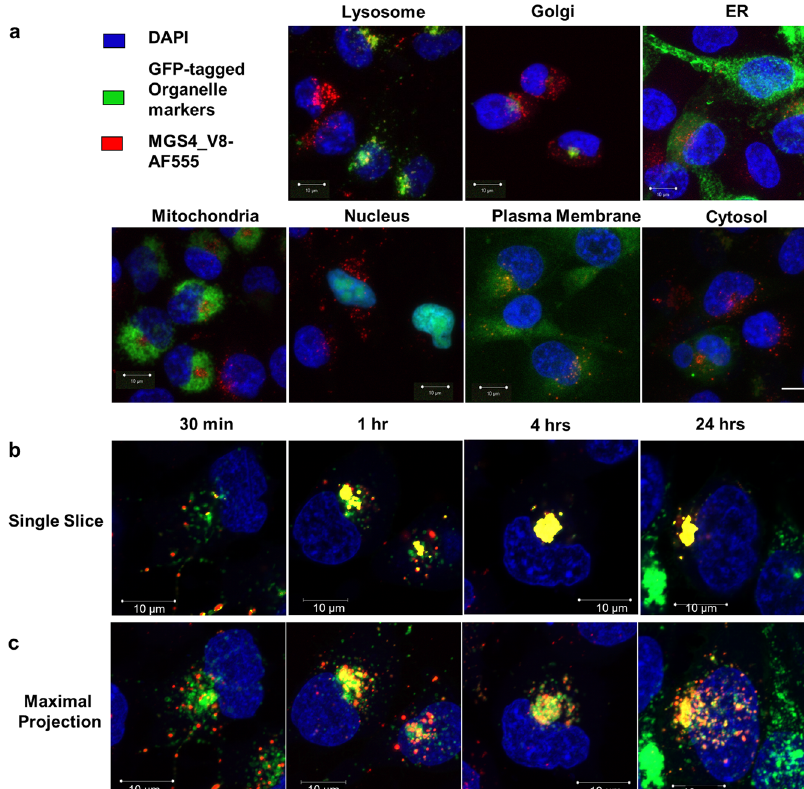
Fig. 3 MGS4_V8 traf fi cs to and accumulates in lysosomes over time. a H1299 cells were labelled with GFP-tagged organelle-speci fi c proteins for ER, Golgi, lysosome, mitochondria, nucleus, plasma membrane, and cytosol (green). Cells were incubated with 50 nM MGS4_V8-Streptavidin Alexa Fluor 555 (red) for 1 h at 37 °C, then fi xed and counterstained with DAPI (blue). MGS4_V8 colocalizes with lysosomes observed as yellow puncta indicated by the red arrows. No signi fi cant colocalization is observed with other subcellular organelles. b Lysosome labelled H1299 cells (green) were incubated with 50 nM MGS4_V8-Streptavidin Alexa Fluor 555 (red) for 0.5, 1, 4, or 24 h, then washed, fi xed, and counterstained with DAPI (Blue). Representative single z-slice images are shown. Peptide- fi lled vesicles can be seen traf fi cking to lysosomes at 30 min, with many already colocalizing by 1 h. Most peptide is found within lysosomes by 4 h and retained there at 24 h. c Maximally projected, compressed z-stacks from images in panel b . The scale bar in all images represents 10 µ